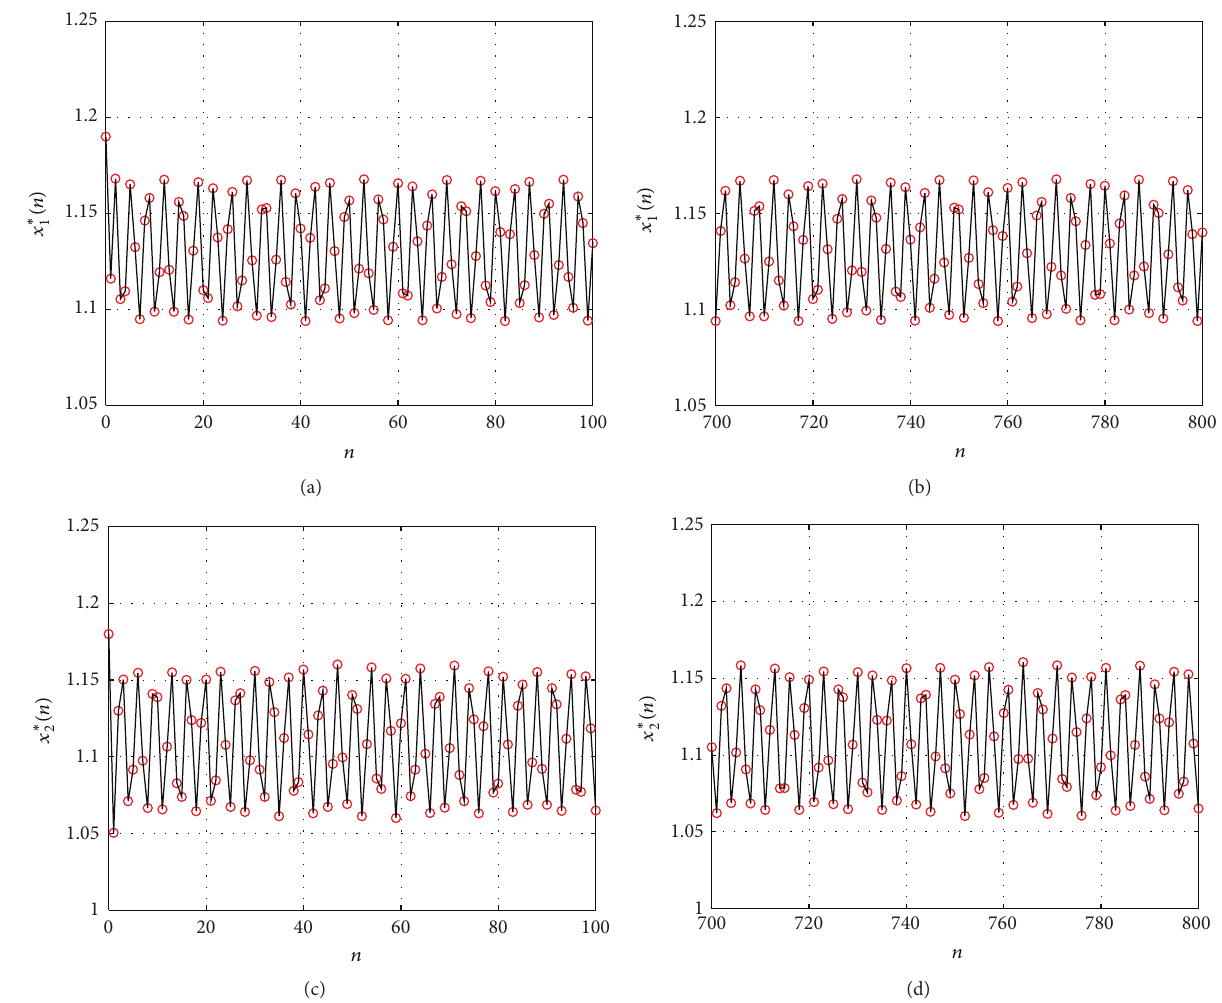
Figure 1: Positive almost periodic solution of system (13). (a), (c) Time-series 𝑥 ∗ 1 (𝑛) and 𝑥 ∗ 2 (𝑛) with initial values 𝑥 ∗ 1 (0) = 1.19 , 𝑥 ∗ 2 (0) = 1.18 for 𝑛 ∈ [0,100] , respectively. (b), (d) Time-series 𝑥 ∗ 1 (𝑛) and 𝑥 ∗ 2 (𝑛) with the above initial values for 𝑛 ∈ [700, 800] ,